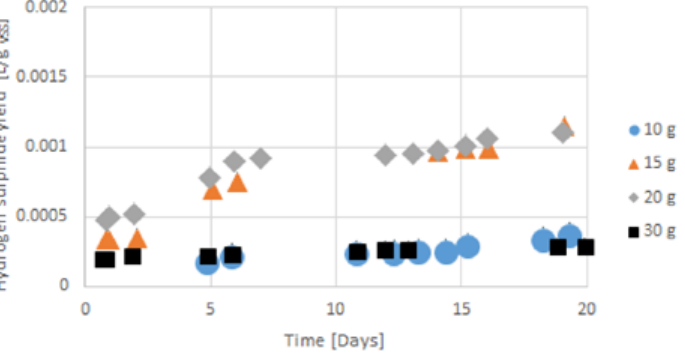
Figure 10. Accumulated hydrogen sulphide emission from gelatine in the first 20 days for gelatine concentration from 10 g VSS/L to 30 g VSS/L.